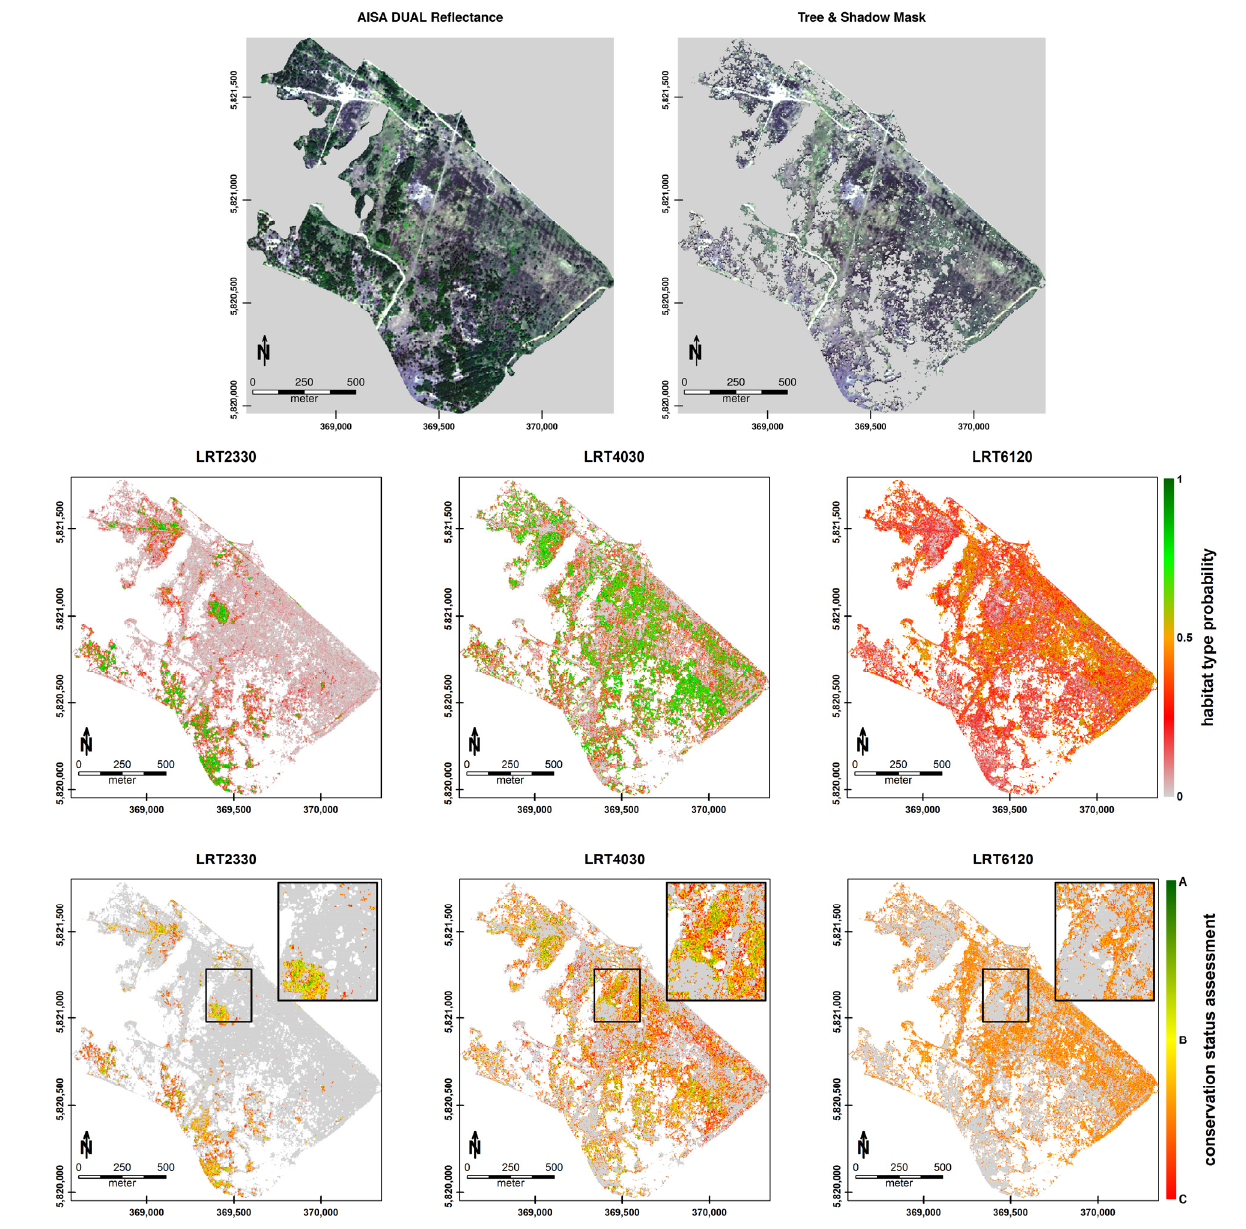
Figure 8. Top panel : AISA DUAL true-color composite image of the test area ( left ); open dryland extraction after masking trees and shadows ( right ). Middle panel : spatial occurrence probability predictions of three habitat types. Bottom panel : continuous habitat type conservation status predictions with color centroids representing status (A: excellent; B: good; C: adverse); a typical transitional area between the three habitat types was exposed in the subplot